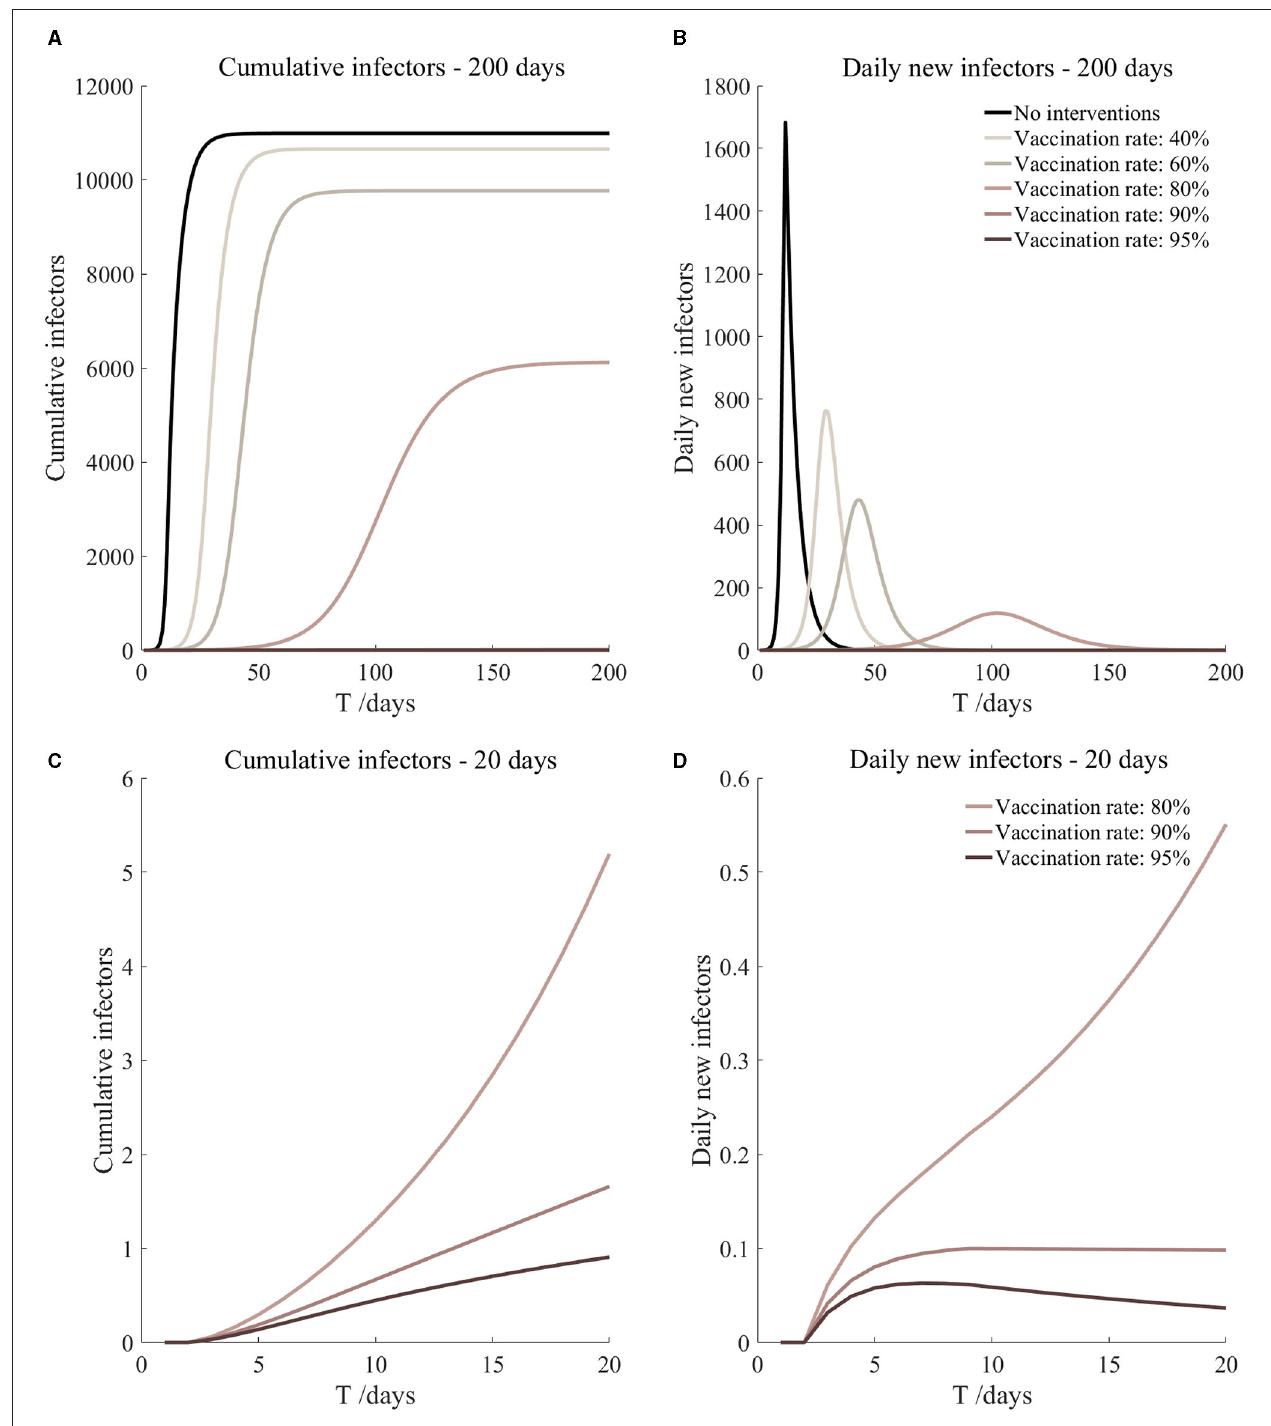
FIGURE 12 | Vaccinated but not quarantined. Assume pre-flight screening can identify 40% of asymptomatic infectors.